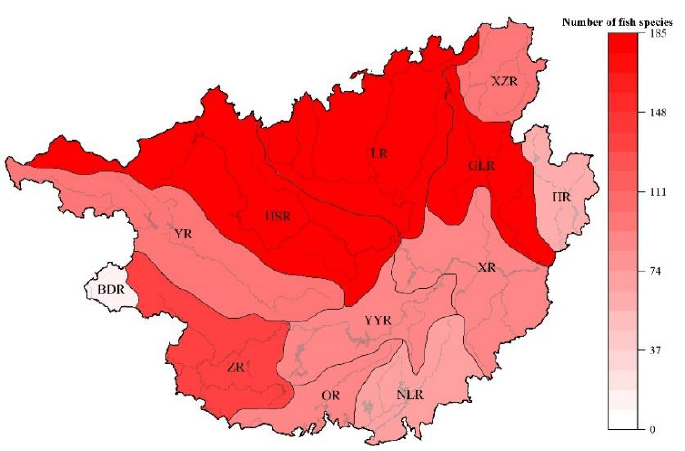
Figure 3. The spatial patterns of fish species numbers in 12 Sub − basins. Sub − basin codes are described in Table 1.